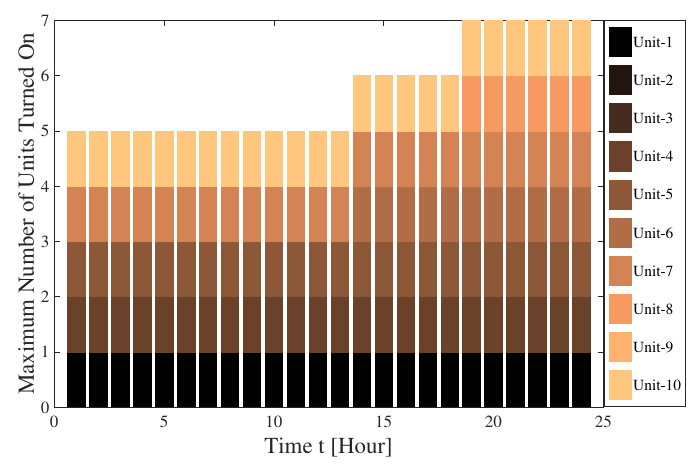
Figure 4. Number of TG units turned on considering ESS.